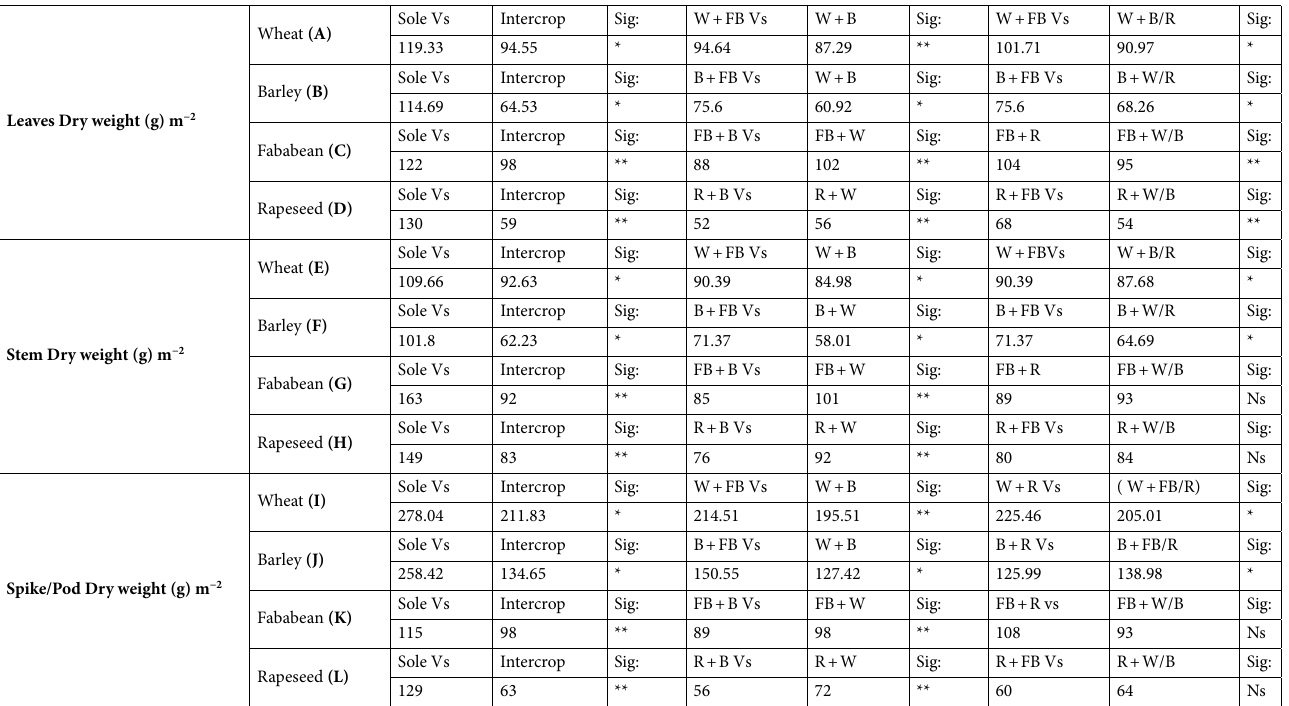
Table 2. Pre-planned comparison of different intercropping systems at anthesis of winter crops as affected by intercropping and irrigation regimes. Where *, ** stands for significant at 5 and 1% level of probability, respectively. W, B, FB and R, stand for wheat, barley, fababean and rapeseed, respectively. Means in the same category are not significantly different if followed by at least one common letter at ( P ≤ 0.05)